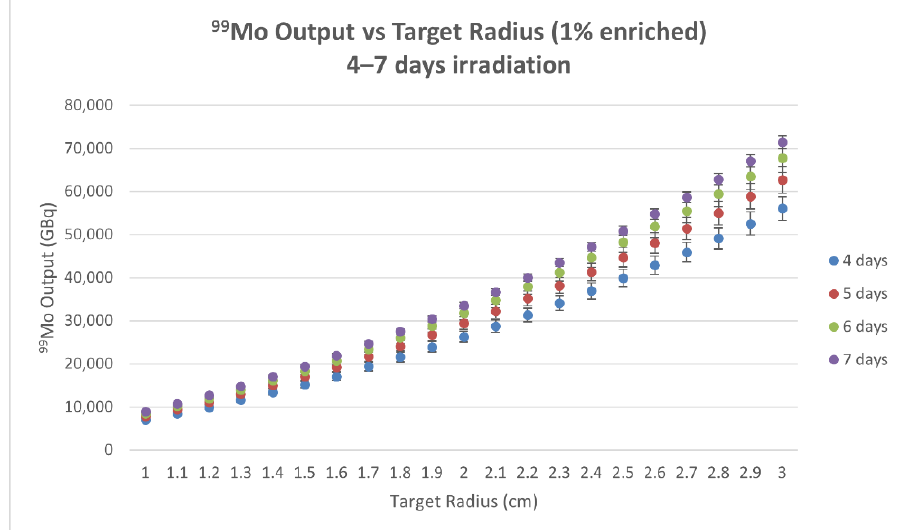
Figure 6. 99 Mo output versus target radius for a fixed target height of 10 cm.